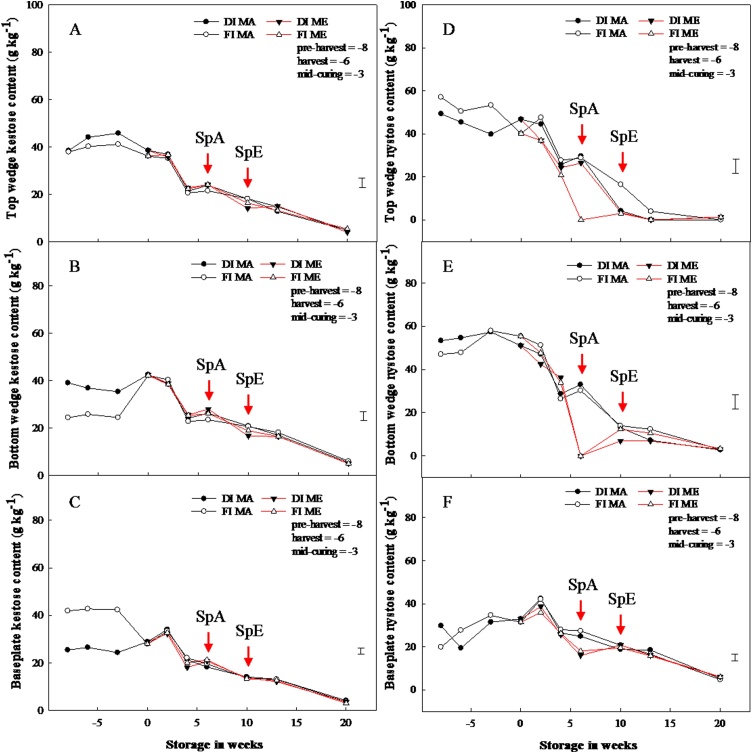
Pre- and postharvest kestose and nystose contents in the top section, bottom section and baseplate of stored onion bulbs treated with and without 1-MCP and ethylene. Kestose and nystose contents per dry weight for the top wedge (A and D), bottom wedge (B and E) and baseplate (C and F) of onion bulbs of cultivar ‘Sherpa’ grown in 2016 under full irrigation (FI) or deficit irrigation (DI); where FI amounted to 100% replenishment of crop evapotranspiration (ETc) and DI was ETc replenishment at 50%. Bulbs were harvested at full maturity (100% fall-down) and cured under glass for six weeks for both years. Post-curing, bulbs were treated with 1-MCP at 1 μL L−1 for 24 h before storage, and were stored at 1 °C under continuous ethylene supplementation at 10 μL L-1 or air. DIMA and FIMA are DI and FI bulbs treated with 1-MCP and stored in air and DIME and FIME are DI and FI bulbs treated with 1-MCP and stored under ethylene. SpA and SpE are sprout emergences for bulbs stored in air and ethylene, respectively. LSD bar at 95% confidence shown.